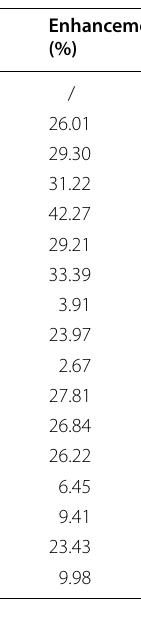
Table 2 Fermentation characteristics of engineered strains with knocked out dehydrogenase genes